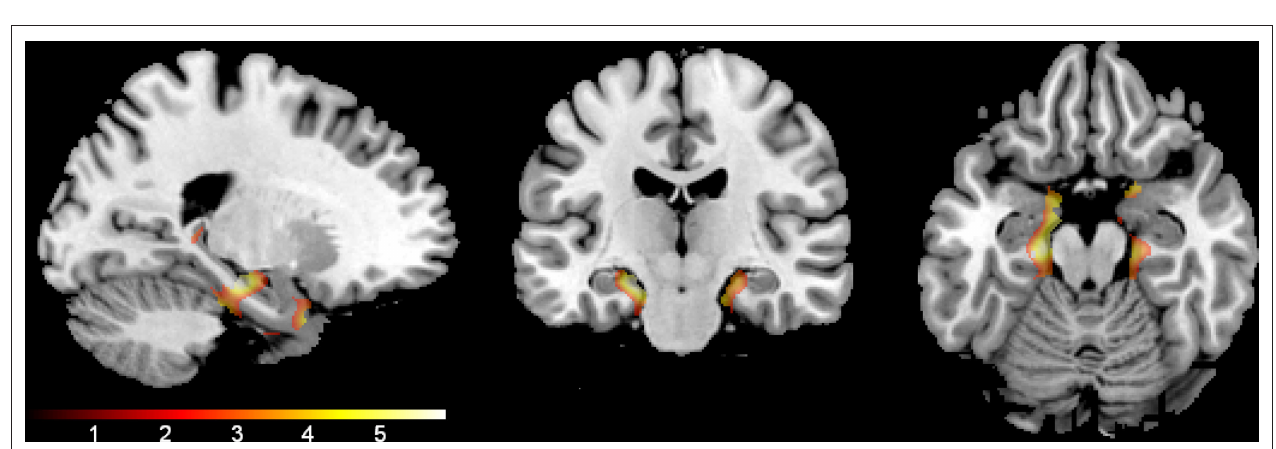
FIguRe 4 | Age effect. The regions where older age was associated with lower gray matter volume are shown. The results are confined to the study’s a priori regions of interest (hippocampi and parahippocampal gyri) and a mask that excludes the significant interaction effect shown in Figure 1 . The color bar represents the height of the t